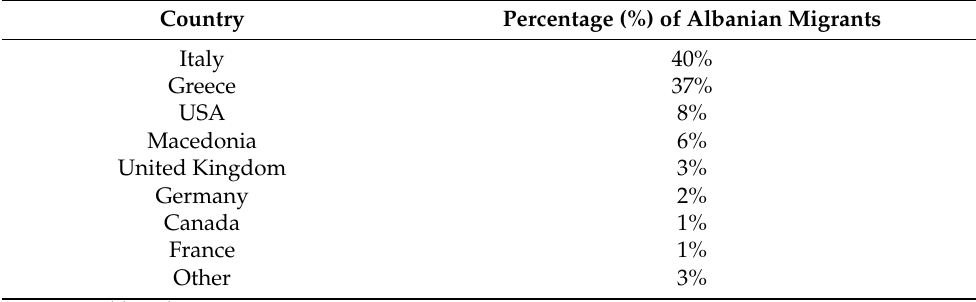
Other 3% Source: World